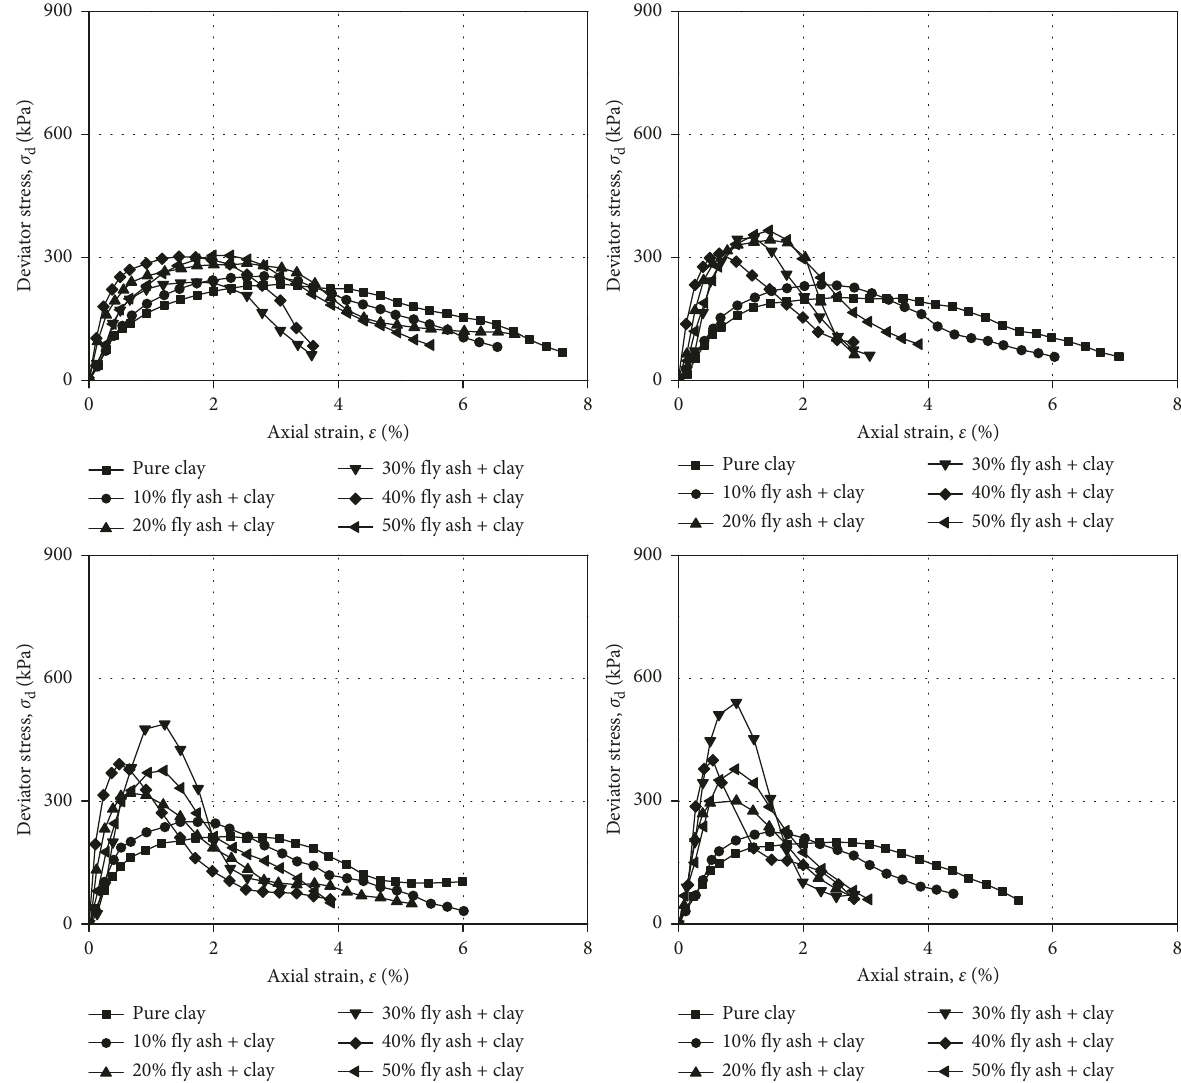
Figure 8: Relationship between deviator stress and axial strain with different fly ash contents under different curing